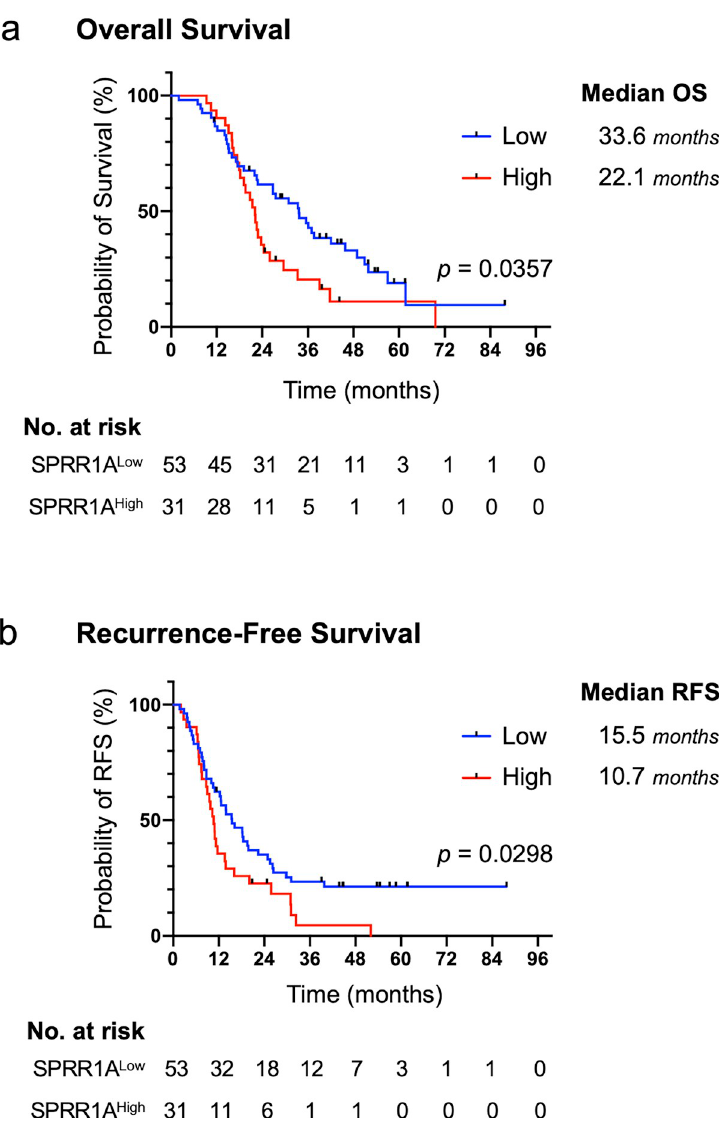
Fig 2. An increased protein expression of SPRR1A was associated with a poor prognosis in PDAC patients. (a) Kaplan-Meier estimates of the OS stratified by the SPRR1A expression. (b) Kaplan-Meier estimates of the RFS stratified by the SPRR1A expression. Tick marks indicate censored data. Kaplan–Meier estimates were compared using a stratified log-rank